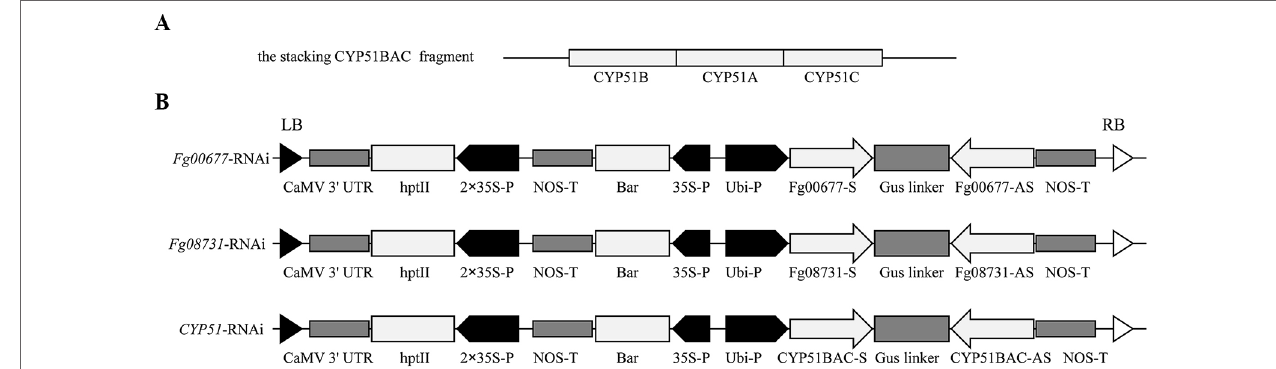
FIGURE 2 | Structure of the RNAi construct. (a) The CYP51BAC fragment was generated by fragment stacking strategy from CYP51A , - B , and - C partial sequences for CYP51-RNAi cassette construction; (B) s tructure of the Fg00677 -RNAi, Fg08731 -RNAi, and CYP51 -RNAi cassette for stable B. distachyon transformation. Each fragment derived from Fg00677 , Fg08731 , and CYP51 in the sense (S) and antisense (AS) orientations was constructed such that the gus linker sequence was inserted between the S and AS sequences. Ubi-P, maize ubiquitin promoter; hpt II, hygromycin resistance gene; 2 × 35S-P, 2× CaMV 35S Promoter; Nos-T, Nos terminator; Bar, Biolaphos resistance